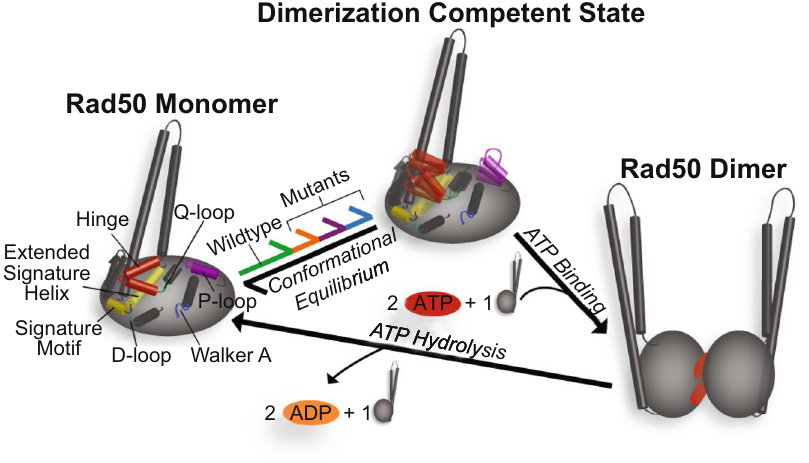
Figure 5. Model for Rad50 NBD “activation” to a binding competent state. Left , illustrates the “ground” state Rad50 NBD with stable interactions between the hinge, extended signature helix, basic switch, and Q-loop. This state is in equilibrium (green reaction arrow) with an ensemble of “Dimerization Competent States,” middle , in which the stable interactions are starting to break and increased side chain dynamics are present. The effect of V156M, V160M, and R805E is to increase the population of this state, as denoted by the orange, purple, and blue reaction arrows. ATP binds to this state, and dimerization can subsequently occur, right . The process is reset by ATP hydrolysis and dimer